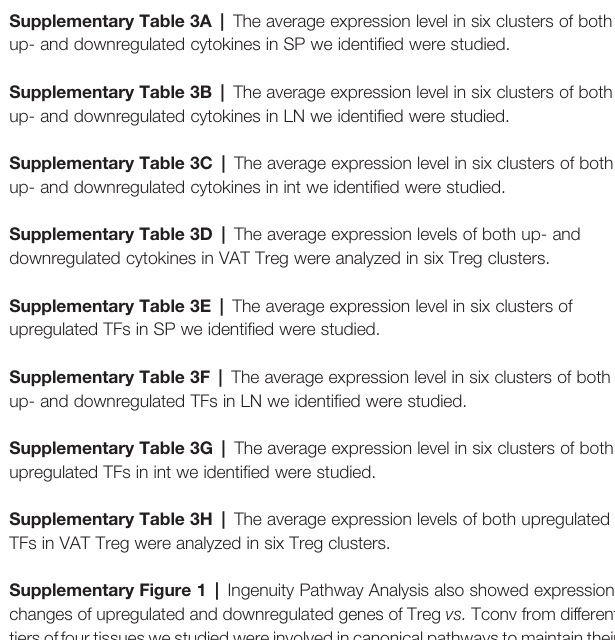
Supplementary Table 1 | Supplemental data of housekeeping gene expressions from the datasets of GSE119169, GSE37532, GSE20366, GSE13306, and GS42276.